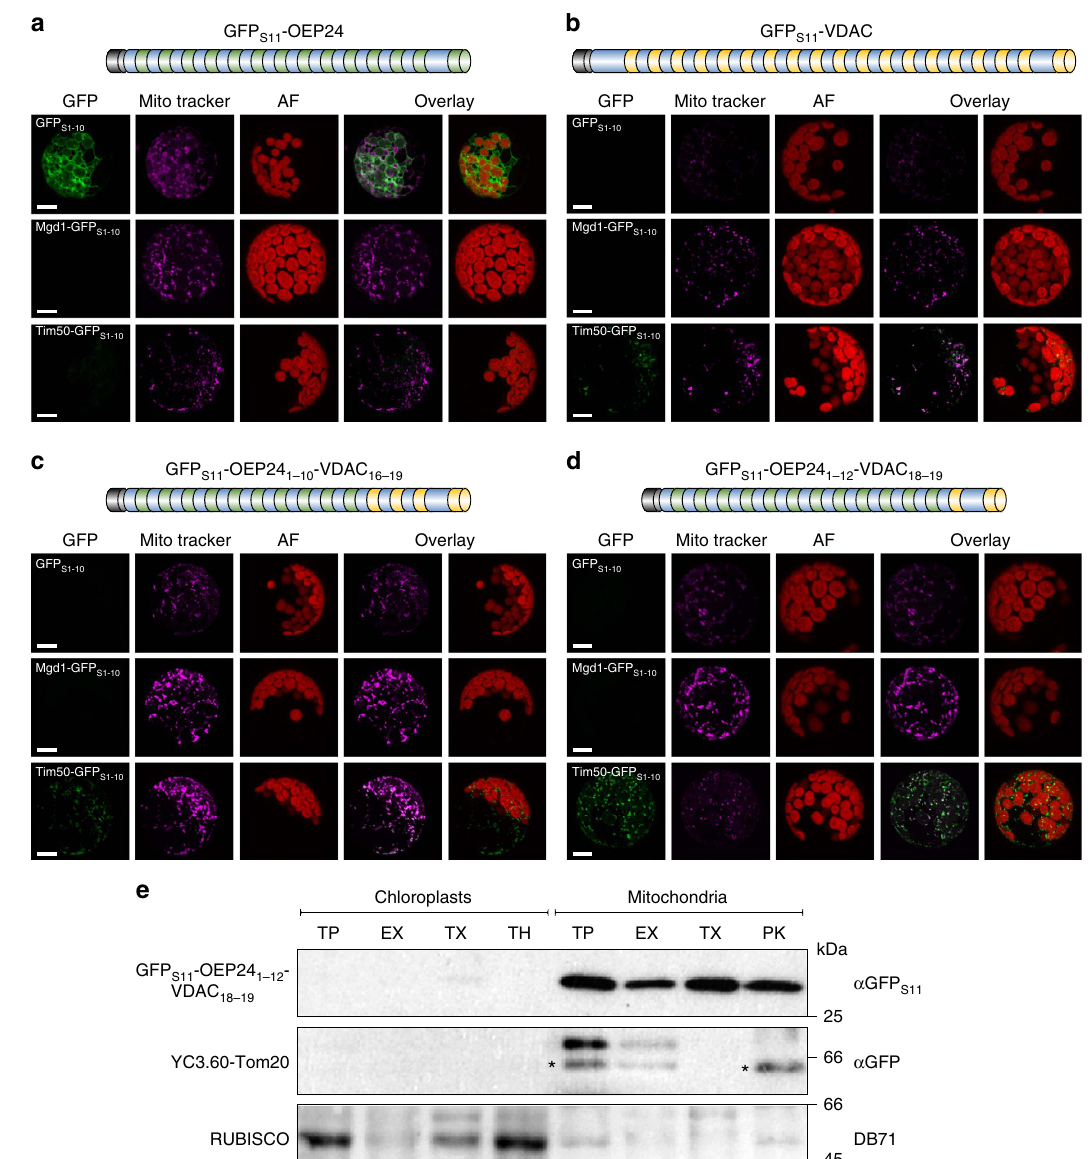
Figure 3 | The last b -hairpin of atVDAC1 directs psOEP24 to mitochondria. ( a – d ) The specified fusion proteins and the indicated reporter constructs were co-transformed into A. thaliana protoplasts. GFP, MitoTracker and chlorophyll autofluorescence (AF) signal as well as the overlays of GFP with either of the latter two for a representative image from at least three independent experiments is shown. Schemes of psOEP24 and constructs generated are shown. Yellow/green sections indicate transmembrane b -strands of atVDAC1 and psOEP24, respectively, and the black section represents the GFP S11 strand. Scale bar, 10 m m. ( e ) Chloroplasts and mitochondria fractions were gained from protoplasts co-transfected with GFP S11 -OEP24 1–12 -VDAC 18–19 and YC3.60-Tom20. Samples of the organelles were analyzed directly (total protein, TP) or they were subjected to carbonate extraction and the pellets were loaded (EX). Other samples were solubilized by Triton X-100 (TX), or treated with thermolysin (TH) or PK. Next, the organelles were analyzed by SDS–PAGE and immunodecoration with the indicated antibodies. DB71 stain of RUBISCO is shown as loading control. YC3.60 is fused to the N terminus of Tom20 and the cytosolic domain of Tom20 is removed by PK. Bands resulting from cross-reactivity of the GFP antibody are marked with an